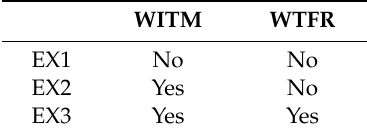
Table 1. Experimental